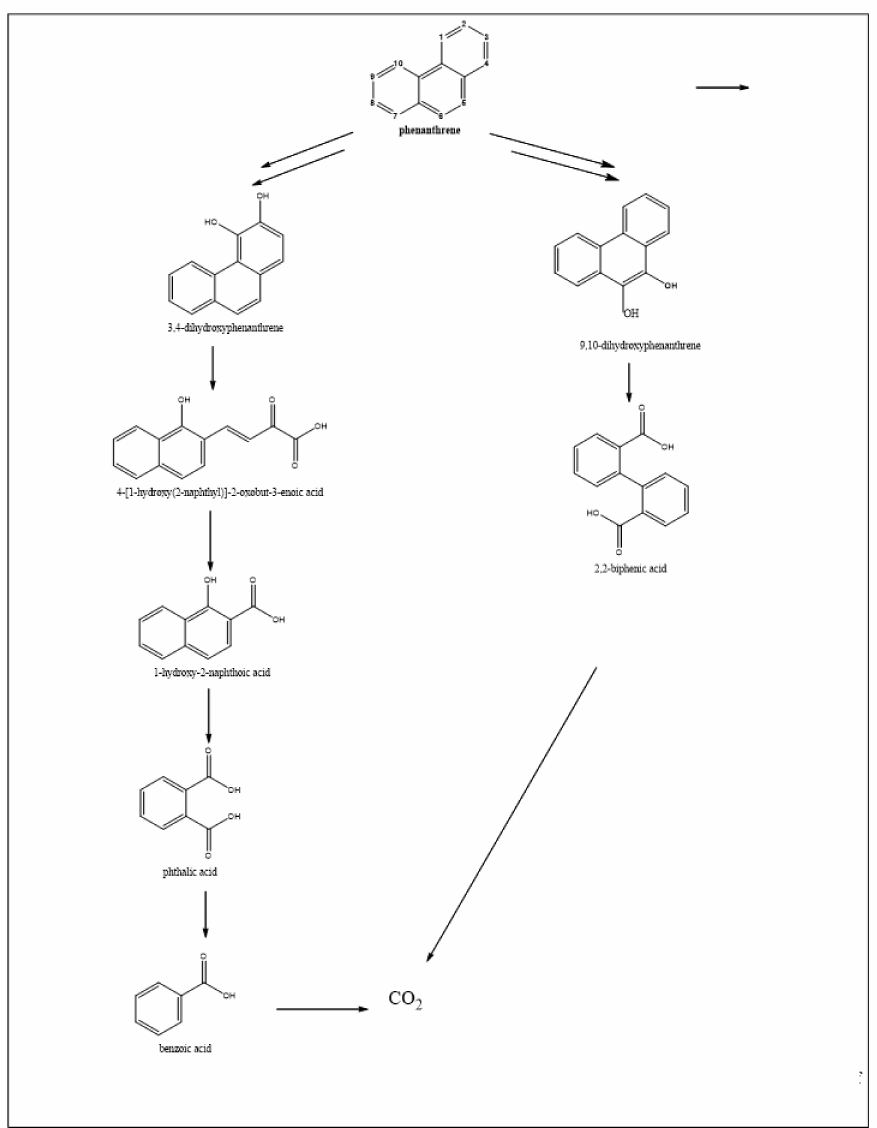
Figure 5. Biodegration pathways of phenanthrene in thermophilic bacteria. All these metabolites were identified from a strain of Nocardia otitidiscaviarum bacterium